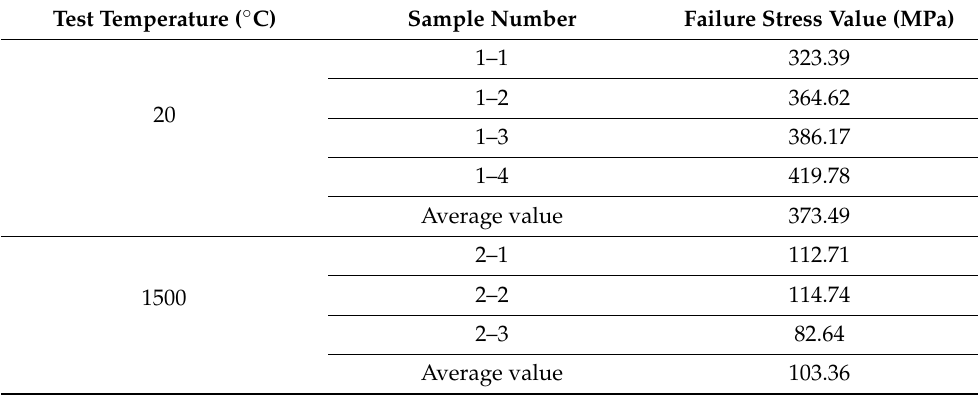
Table 1. Mechanical test